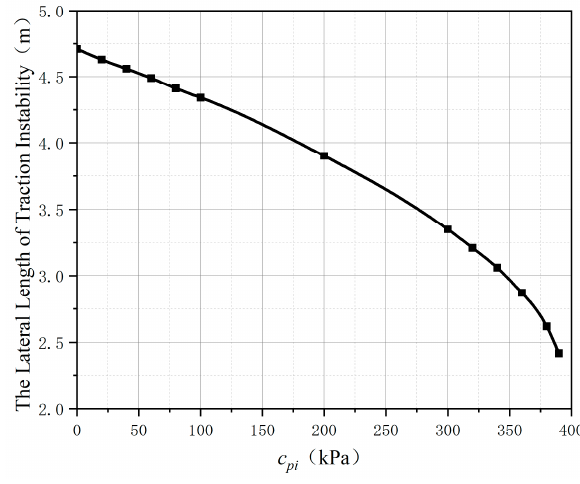
Figure 15. Influence of c pi on the lateral length of traction instability.